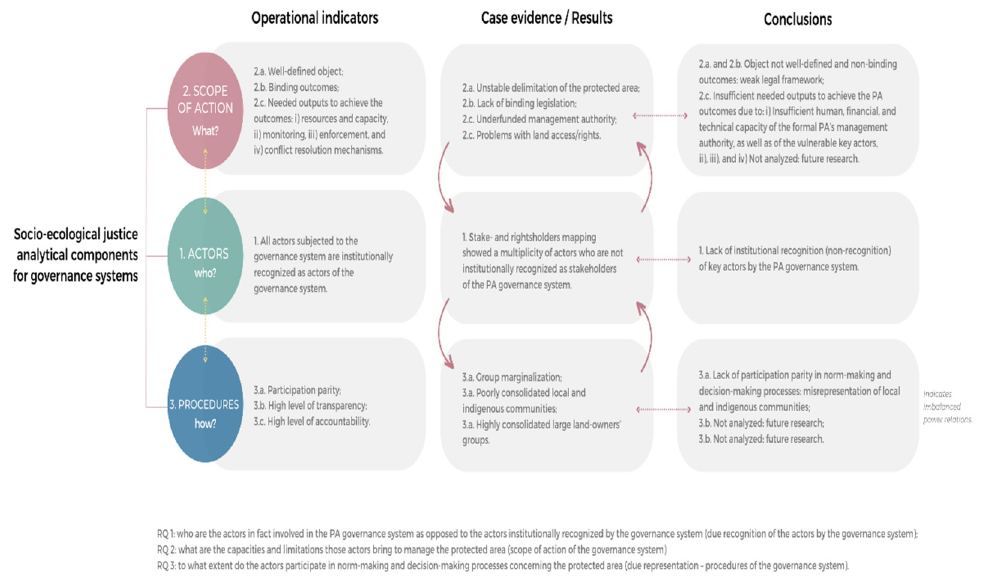
Figure 5. Summary of results connecting operational indicators to case evidences.